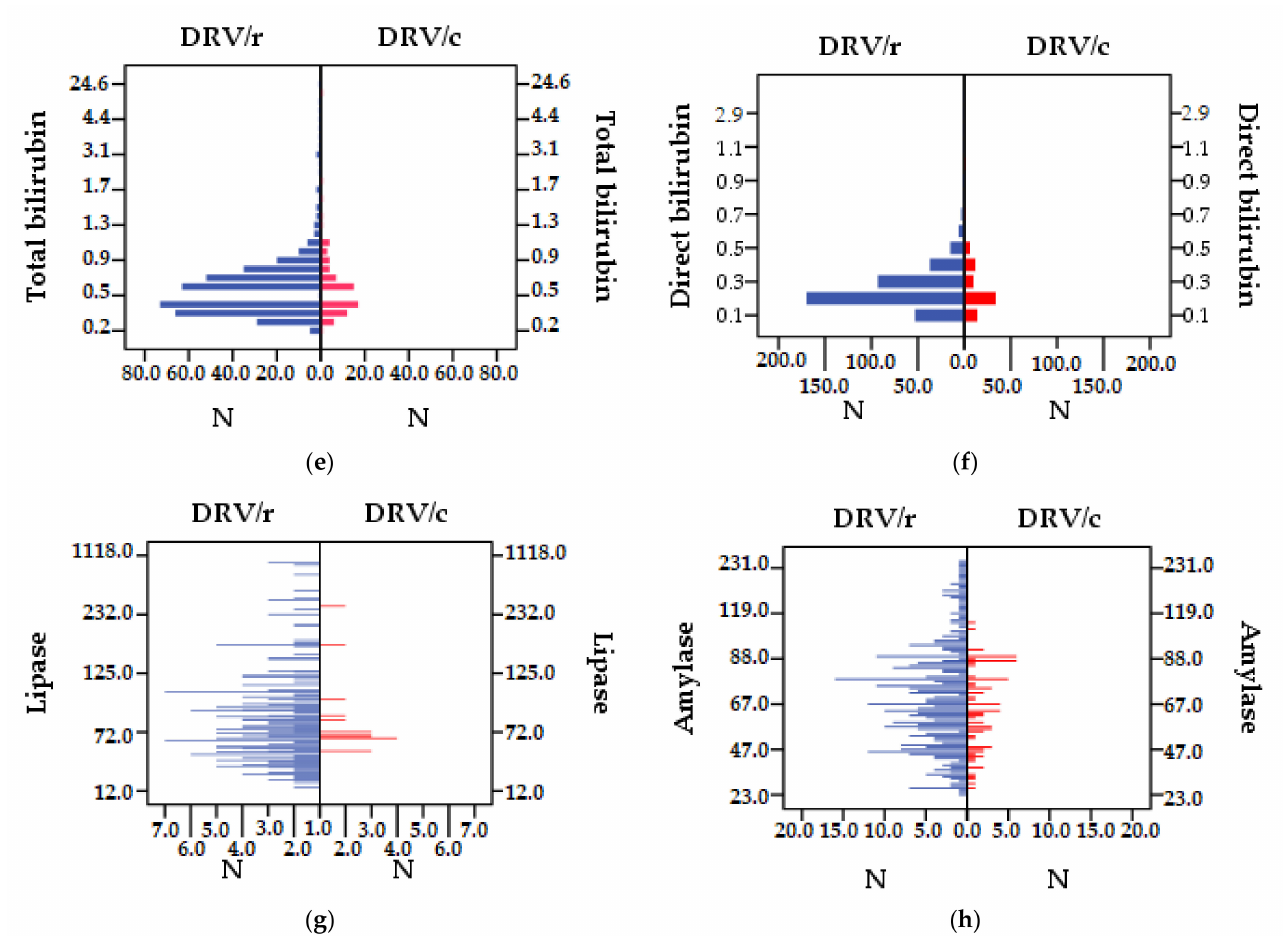
Figure 6. Difference between DRV/r and DRV/c groups as values of liver and pancreatic function parameters: ( a ) ALP/GPT (IU/L), ( b ) AST/GOT (IU/L), ( c ) GGT (IU/L), ( d ) IU/L), ( e ) total bilirubin (mg/dL), ( f ) direct bilirubin (mg/dL), ( g ) lipase (IU/L), ( h ) amylase